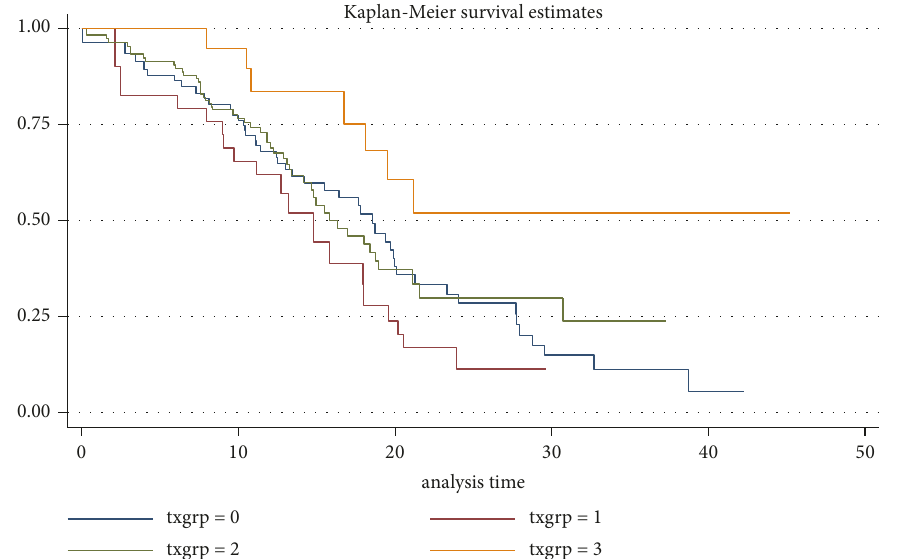
Figure 4: Progression to EDSS 4 by treatment group (unadjusted). The unadjusted analysis includes all treatment periods. Groups 0-2 are not significantly different, while group 3 appears to progress slower. However, the sample in group 3 is small (91 patients). txgrp 0 = no treatment; txgrp 1 = gammaglobulins, azathioprine, and cyclophosphamide; txgrp 2 = interferons and glatiramer acetate; txgrp 3 = natalizumab and